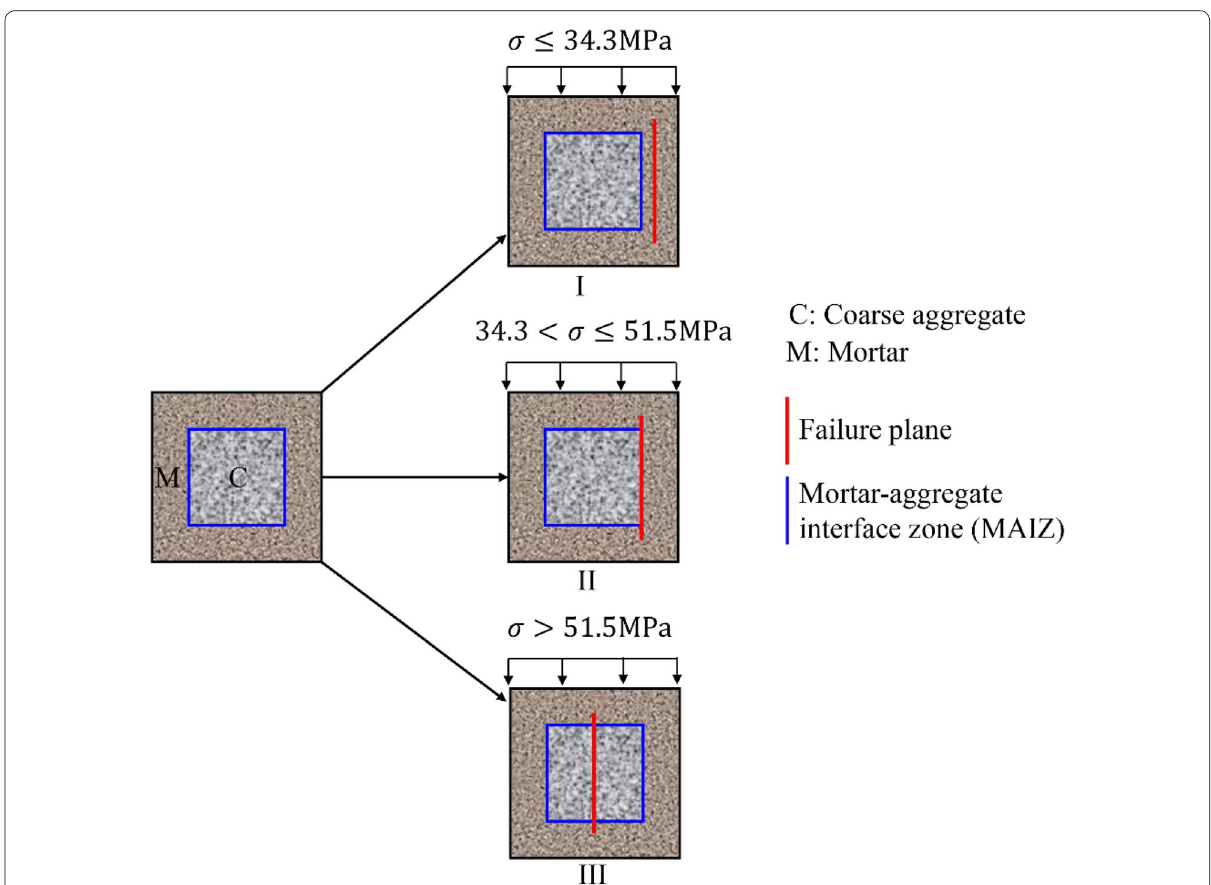
Fig. 13 The schematic diagram of concrete failure type under